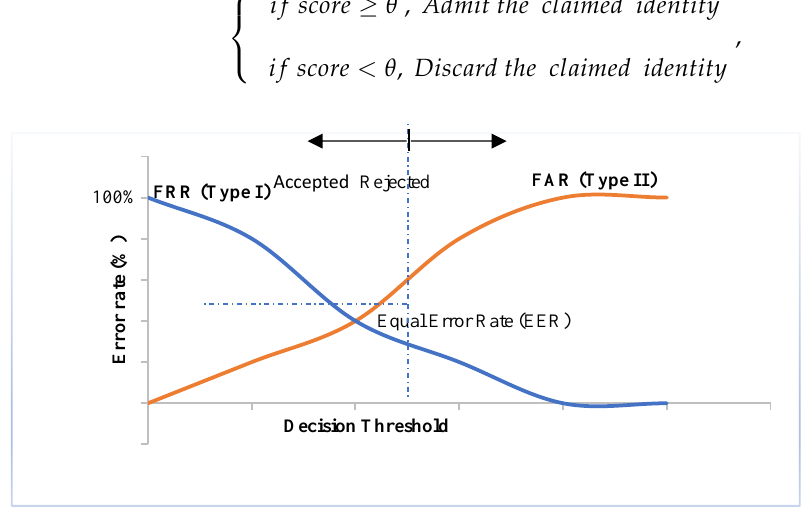
Figure 6. Graphical illustration of equal error rate (EER) in verification systems.